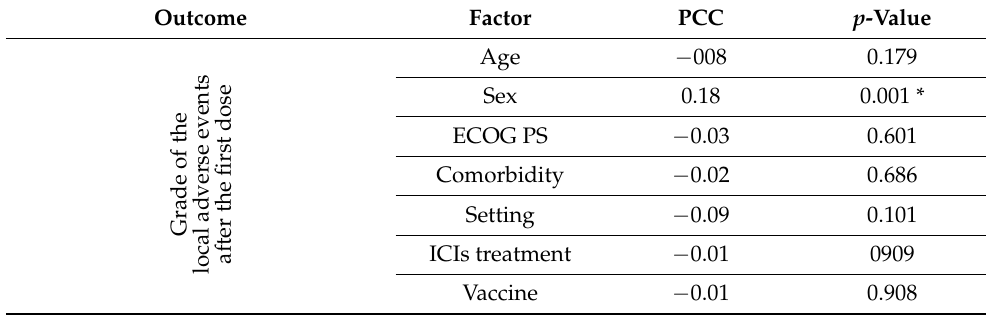
Table 4. Multiple linear regression of the clinical factors influencing the continuous outcomes based on the adverse events grade. Age: (0) <65, (1) ≥ 65; Sex: (0) M, (1) F; ECOG PS: (0) 0, (1) 1, (2) ≥ 2; Comorbidity: (0) no, (1) ≤ 2, (2) ≥ 3; Setting: (0) adjuvant and neoadjuvant, (1) metastatic; ICIs treatment: (0) no, (1) yes; Vaccine: (0) with mRNA, (1) with viral vector. PCC: partial correlation coefficient; *: p -values reaching statistical